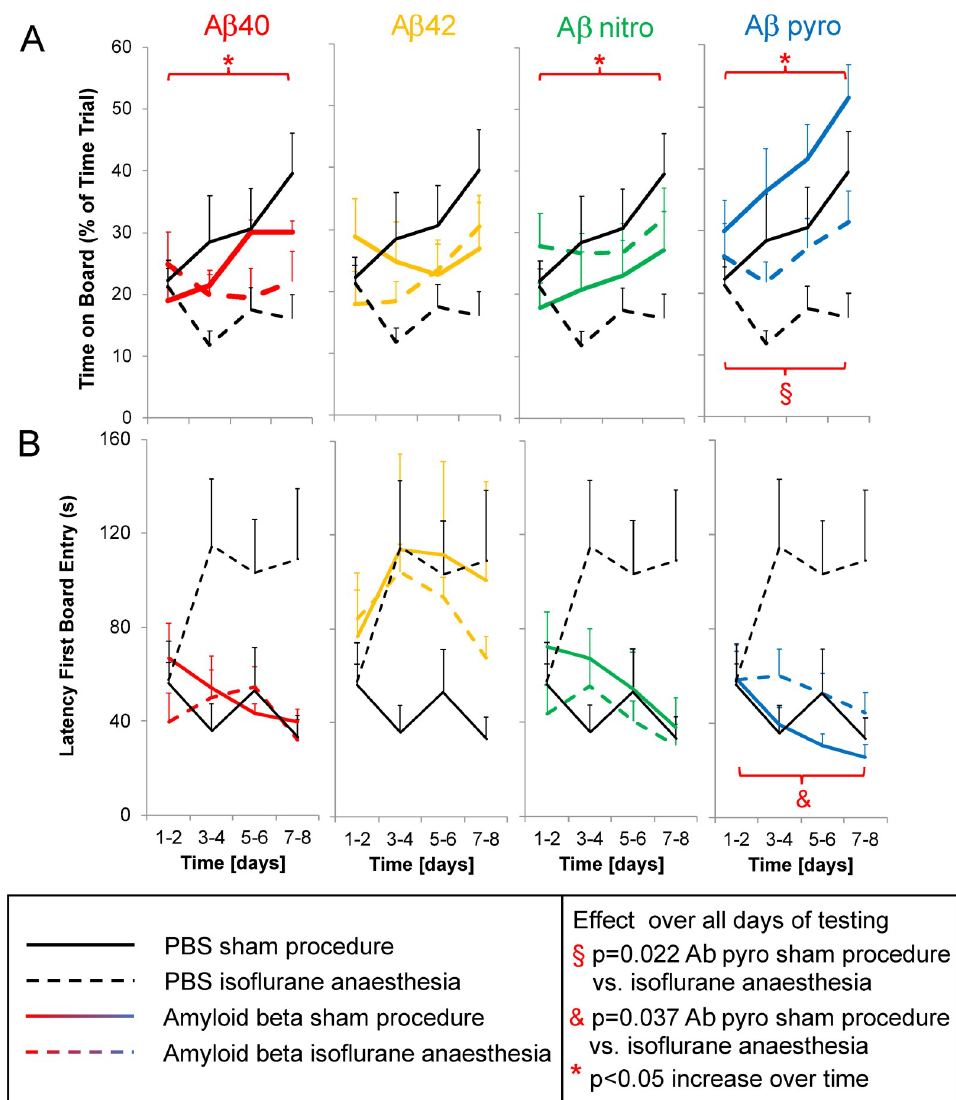
Fig 2. Anxiety-related behavioural changes after anaesthesia in mice injected with different A β subspecies compared to control. A: Time on Board, B: Latency First Board Entry (both anxiety); mean of all tests on two days and standard error